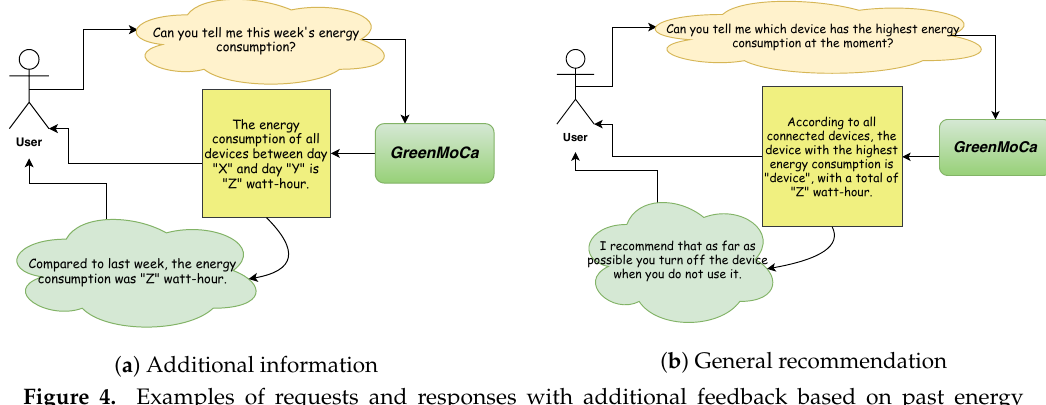
Figure 4. Examples of requests and responses with additional feedback based on past energy consumption measures and recommendations to promote